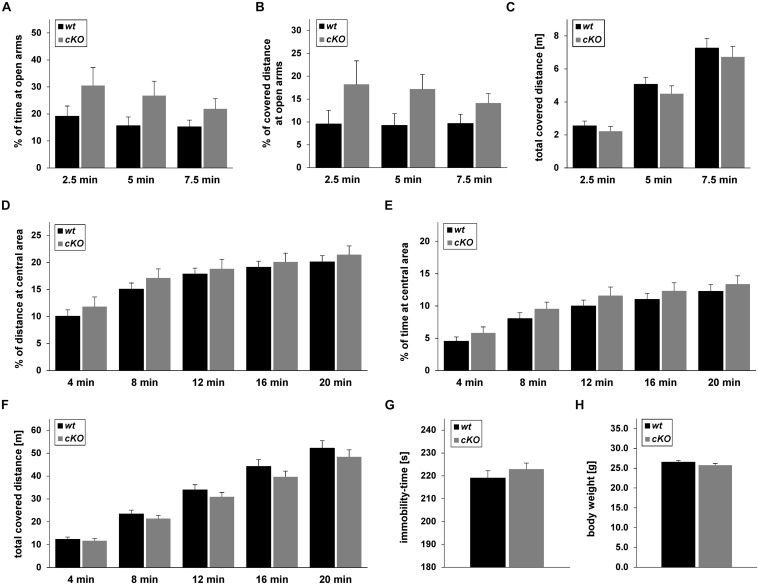
Behaviour of Tgfβ2flox/flox:Krox20+/+ (wt) and Tgfβ2flox/flox:Krox20cre/+ (cKO) mice. Exploratory behaviour and spontaneous activity of wt (n = 16) and cKO (n = 17) mice was recorded for 7.5 min in an elevated plus maze (A–C) and 20 min in an open field test (D–F). Percentage of time spent on (A) and percentage of covered distance at (B) open arms for the first 2.5, 5, and 7.5 min of the elevated plus maze experiment. (C) Total covered distance for the same periods. Spontaneous activity of wt (n = 18) and cKO (n = 17) mice was recorded for 20 min in the open field arena. Evaluation of data was subdivided in time slots, each one 4 min longer than the previous one. Percentage of time spent (D) and percentage of covered distance (E) at the inner area of the open field. (F) Total distance covered during the habitation period in the open field. (G) Immobility-time of wt (n = 15) and cKO (n = 17) animals in the forced swim test (FST). (H) Body weight of adult (12 weeks) wt (n = 27) and cKO (n = 29) mice. Data were analysed using two-tailed Student’s t-test. Data are given as mean ± SEM.